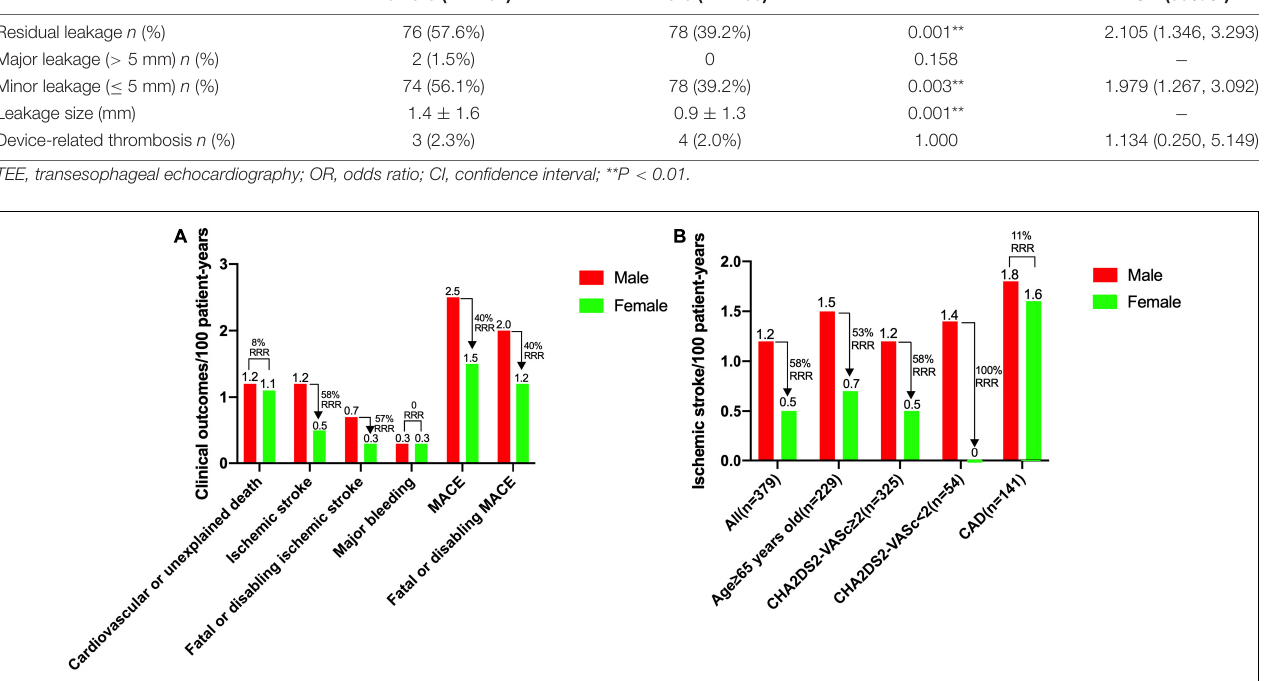
FIGURE 2 | Rates of clinical outcomes between female and male patients. (A) Rates for cardiovascular or unexplained death, ischemic stroke, fatal or disabling ischemic stroke, major bleeding, MACE and fatal or disabling MACE. (B) Rates of ischemic stroke for overall population, patients with age ≥ 65 years, patients with CHA2DS2-VASc score ≥ 2, patients with CHA2DS2-VASc score < 2, and patients with a history of CAD. CAD, coronary artery disease; MACE, major adverse cardiovascular events, including cardiovascular or unexplained death, ischemic stroke or major bleeding; RRR, relative risk